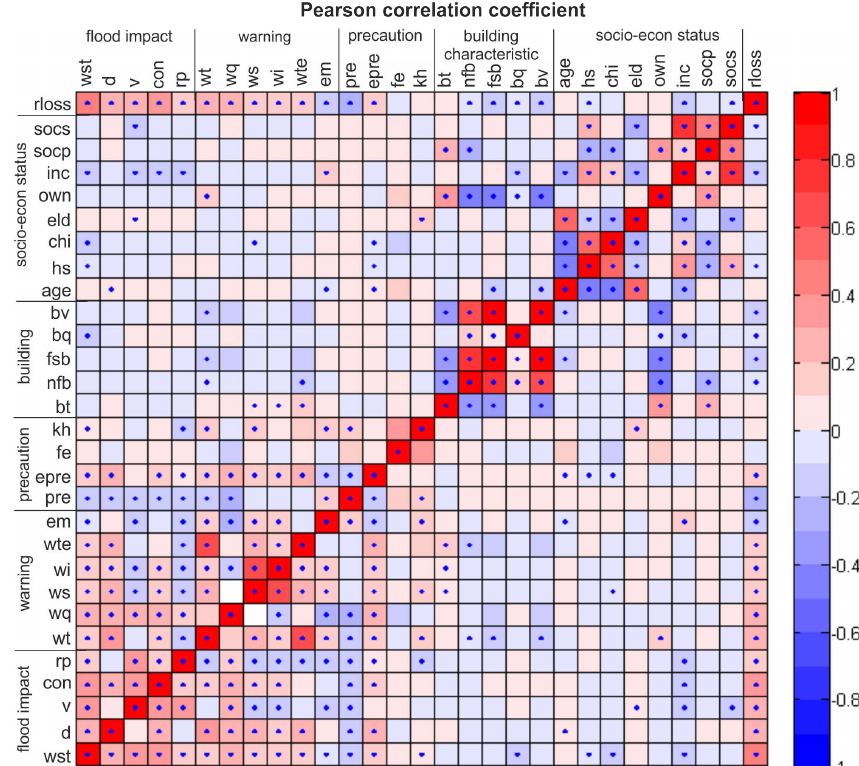
Fig. 1. Pearson correlation of the 29 variables (28 candidate predictors, see Table 1, and loss ratio). Significant correlation (1% significance level) is marked by a